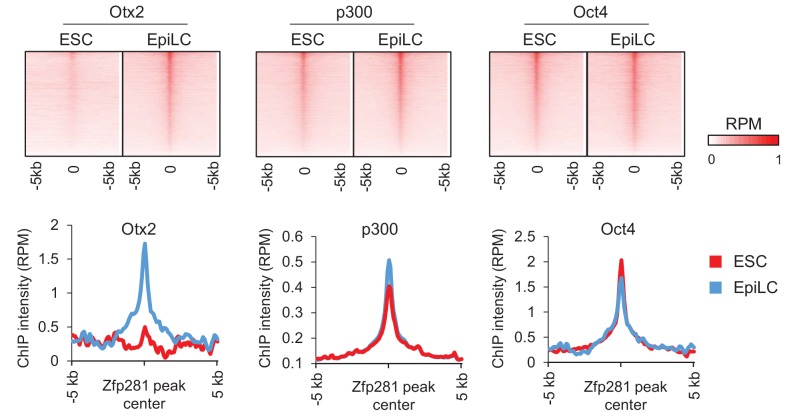
Zfp281, Oct4, and P300 colocalize in ESCs and EpiSCs/EpiLCs.ChIP-seq profiles of Otx2, p300, and Oct4 (Buecker et al., 2014) at Zfp281 peak regions in ESCs and EpiLCs. Intensity is plotted within 5 kb around Zfp281 peak center in ESCs and EpiSCs, respectively.